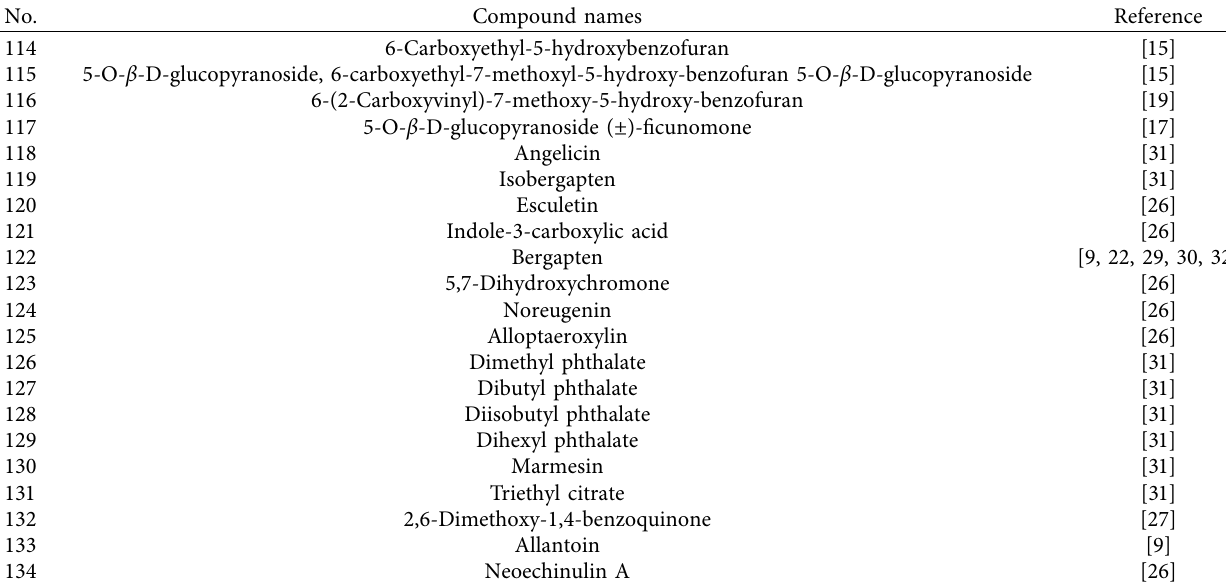
Table 5: Other compounds found in F. tikoua